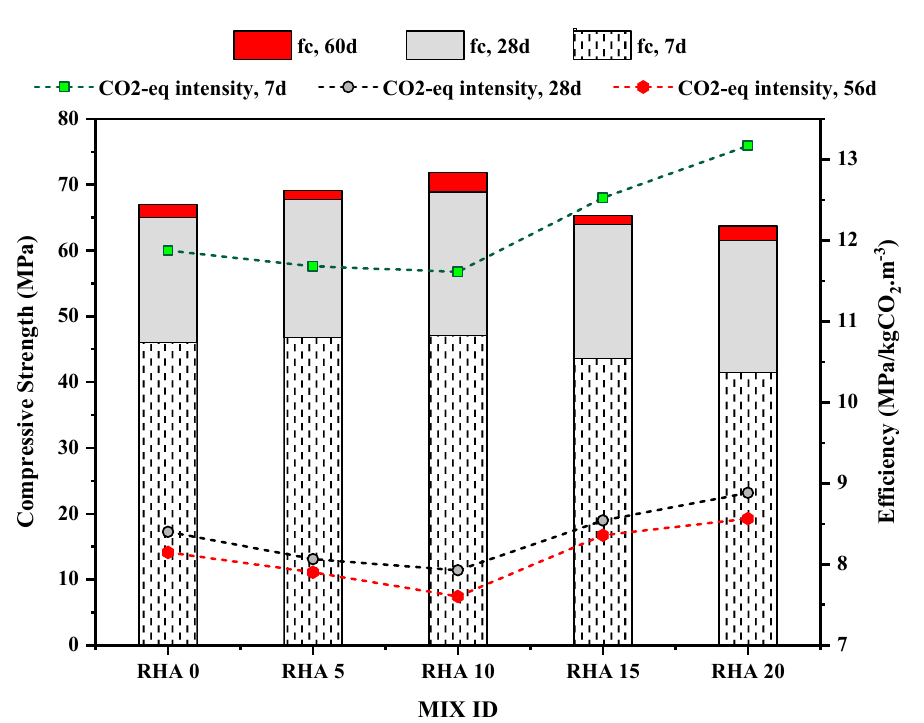
Figure 19. Eco-strength efficiency with respect to compressive strength.